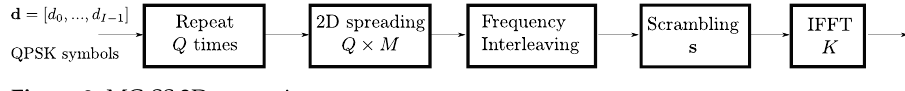
Figure 2. MC-SS 2D transmitter structure.